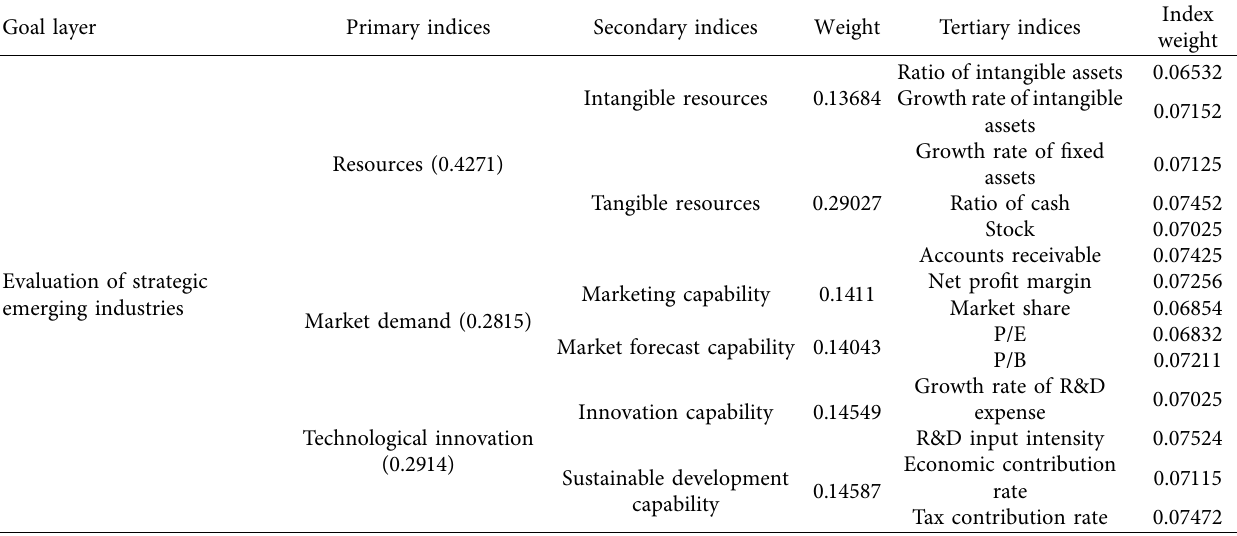
Table 1: Evaluation indices and their